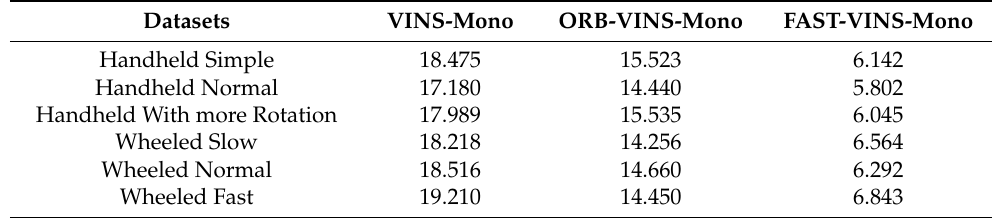
Table 3. Time of VIO front-end per frame comparisons between three different methods in milliseconds.